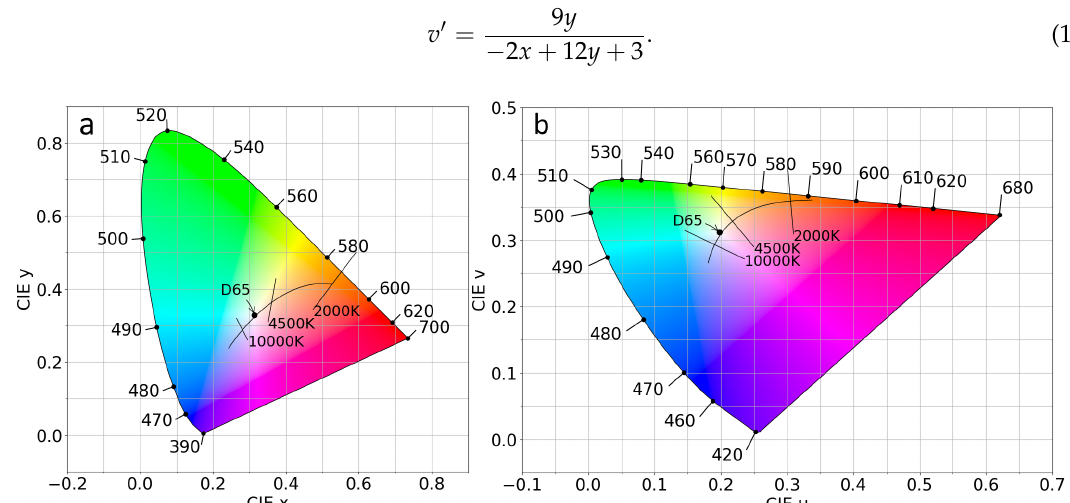
Figure 6. ( a ) The CIE 1931 chromaticity diagram with chromaticity coordinate values ( x , y ) of the D65 illuminant (average sunlight) and the Planckian locus. ( b ) CIE 1960 Uniform Color Space (UCS) . chromaticity diagram with chromaticity coordinate values ( u , v ) of the D65 illuminant and the Planckian locus. The extended lines represent